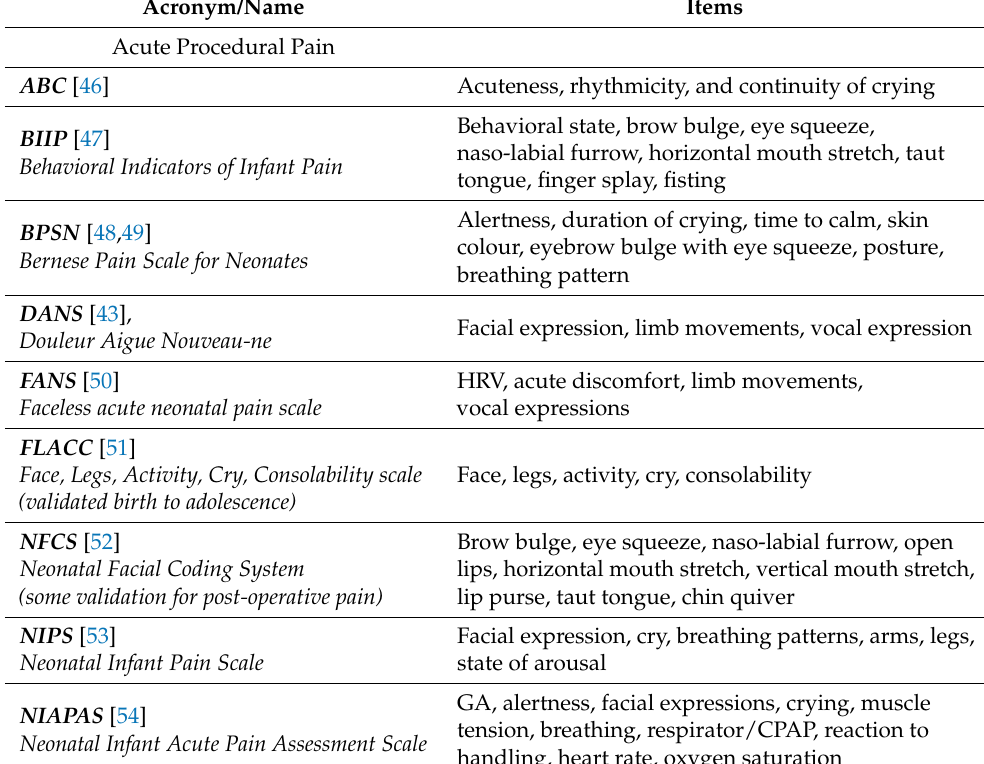
Table 2. Pain Assessment Tools for Term and Preterm